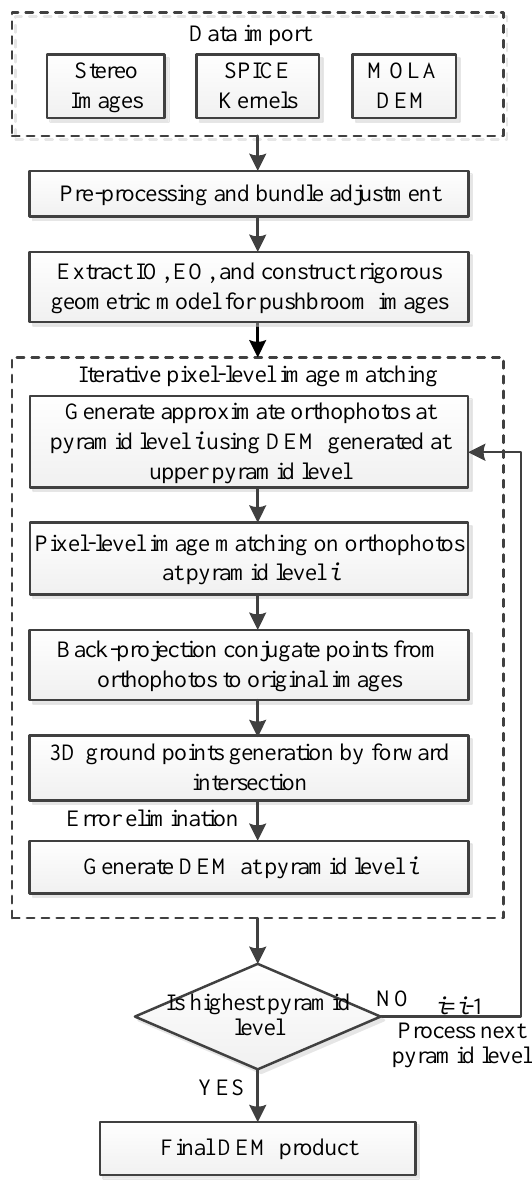
Figure 3. The pixel-level image matching and DEM generation